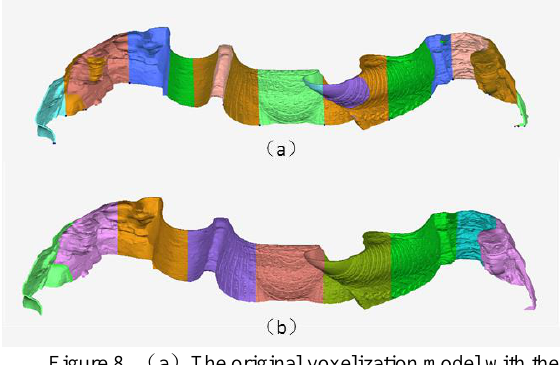
Figure 8. （ a ） The original voxelization model with the fourth layer as an example （ b ） Merged fourth layer sub-models